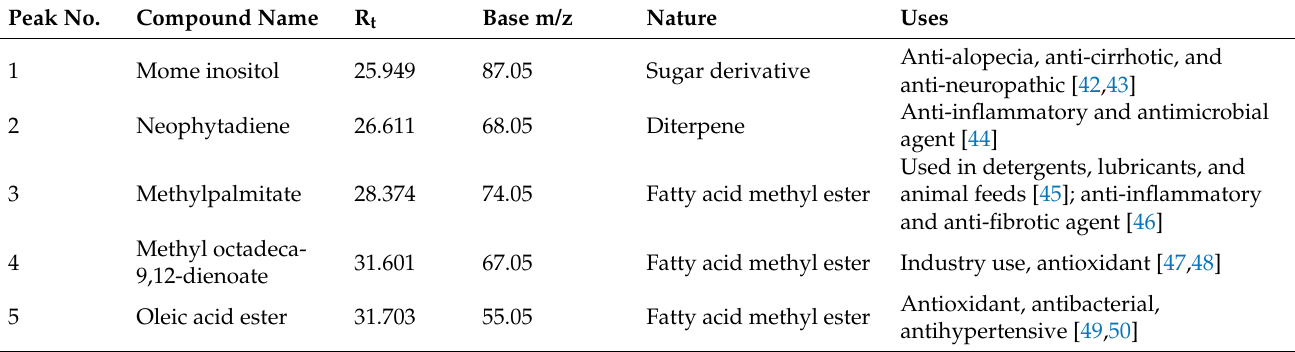
Table 7. GC-MS-identified compounds present in methanol extract of F. arabica .